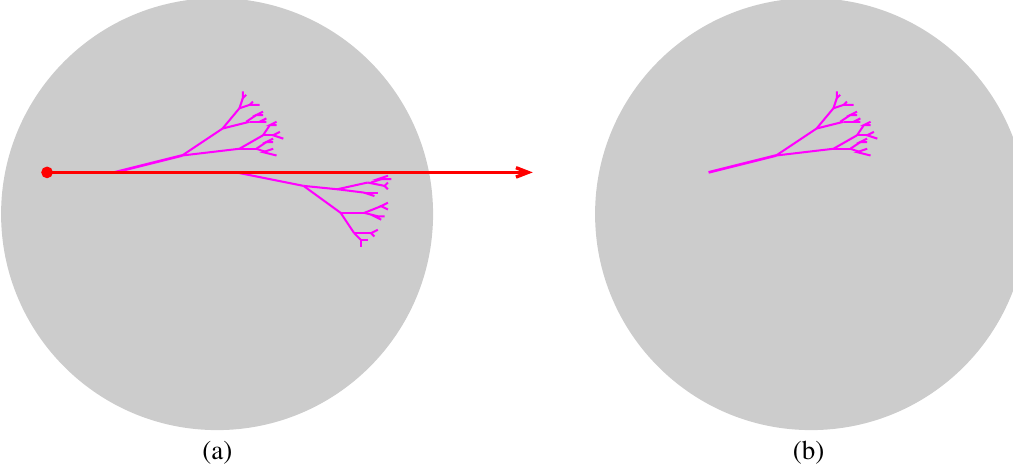
Figure 1 . (a) A cartoon of in-medium energy loss of a high-energy parton traversing a quark- gluon plasma. (Initial vacuum-like radiation associated with the hard event that created the initial particle is not shown. Vacuum-like radiation and then hadronization of a high-energy particle that leaves the medium is also not shown.) (b) Depiction of a branch that deposits all of its energy in the